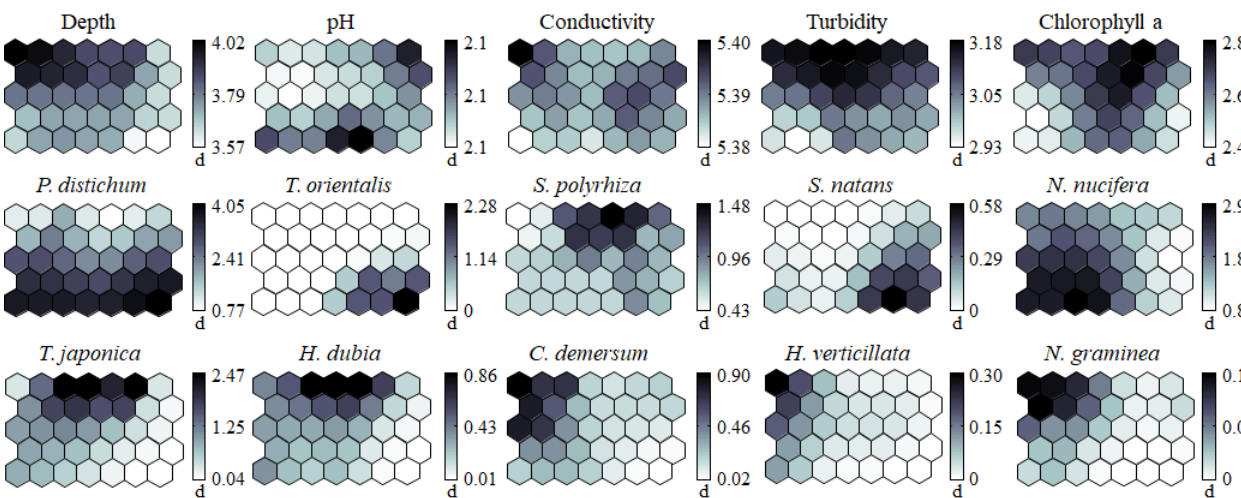
Figure 5. Segmentation of the data between environmental variables and biomass per macrophyte species. The distribution is partitioned according to macrophyte species. Cluster orientation is the same as in Figure 4.